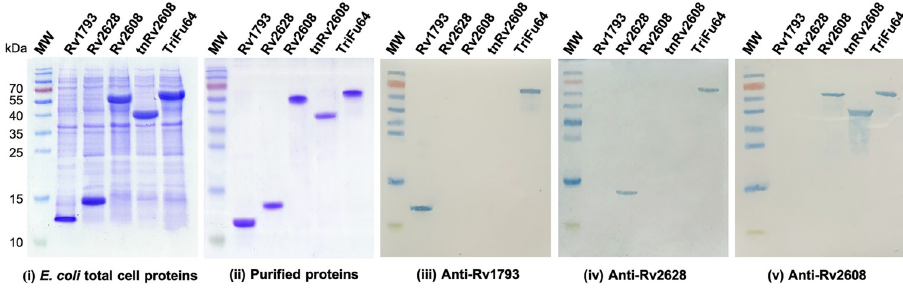
Fig 2. Immunostimulatory activity of Mtb antigens produced in E . coli . SDS-PAGE analysis of the recombinant proteins expressed in E . coli . (i) Total cell proteins (ii) purified antigens, Western Blots of the purified proteins show the recognition of the individual proteins by rabbit polyclonal antiserum both in the individual and fusion antigens (iii: Anti-Rv1793; iv: Anti-Rv2628 & v: Anti-Rv2608).